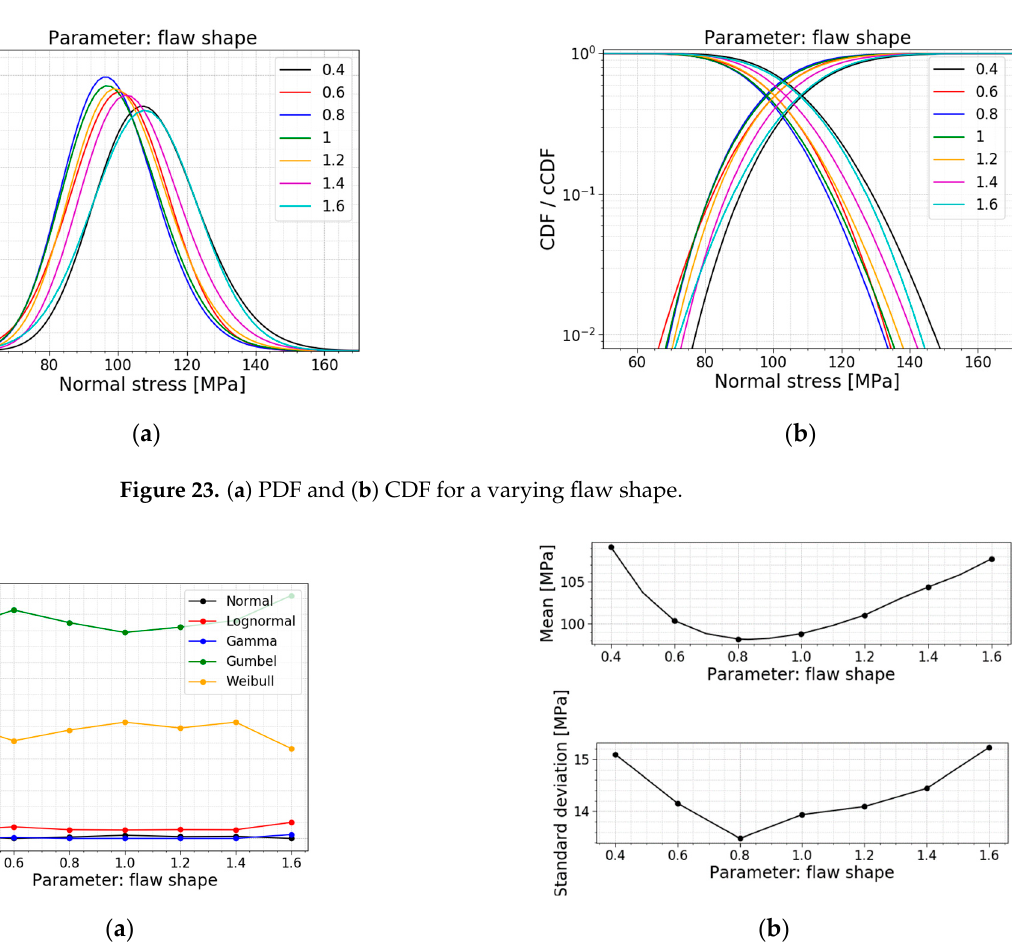
Figure 24. ( a ) AIC values and ( b ) the mean and st.dev. of the normal stress at failure for a varying flaw shape.